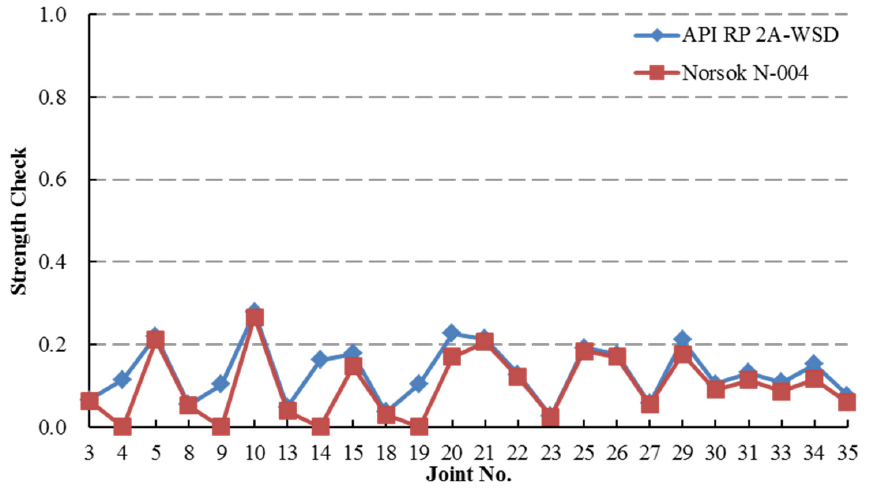
Figure 28. Joint Strength Check (Case 4).